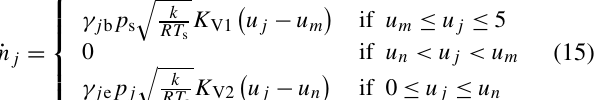
celeration and was calculated by an approximation of second differentiation of the measured piston position. The noise in the calculated acceleration signal was filtered by an acausal first order low-pass filter with a bandwidth of 32